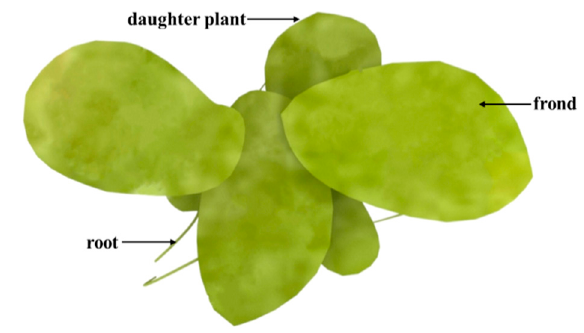
Figure 2. Schematic diagram of Landotia punctata .